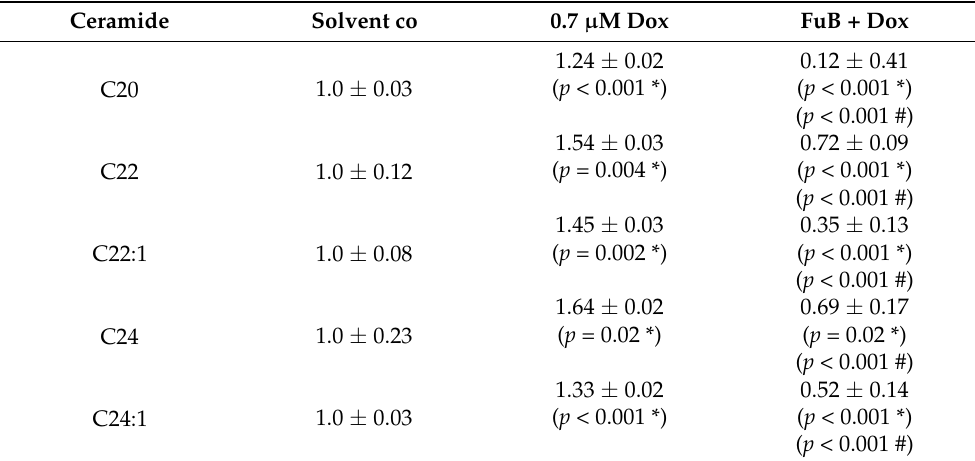
Depicted are mean values and standard deviation of three independent measurements. Significance was calculated with a t -test ( p ≤ 0.05). * = significant to solvent co. # = significant to 0.7 µ M Dox.). solvent co = solvent control. Dox = Doxorubicin, FuB = Fumonisin B1.